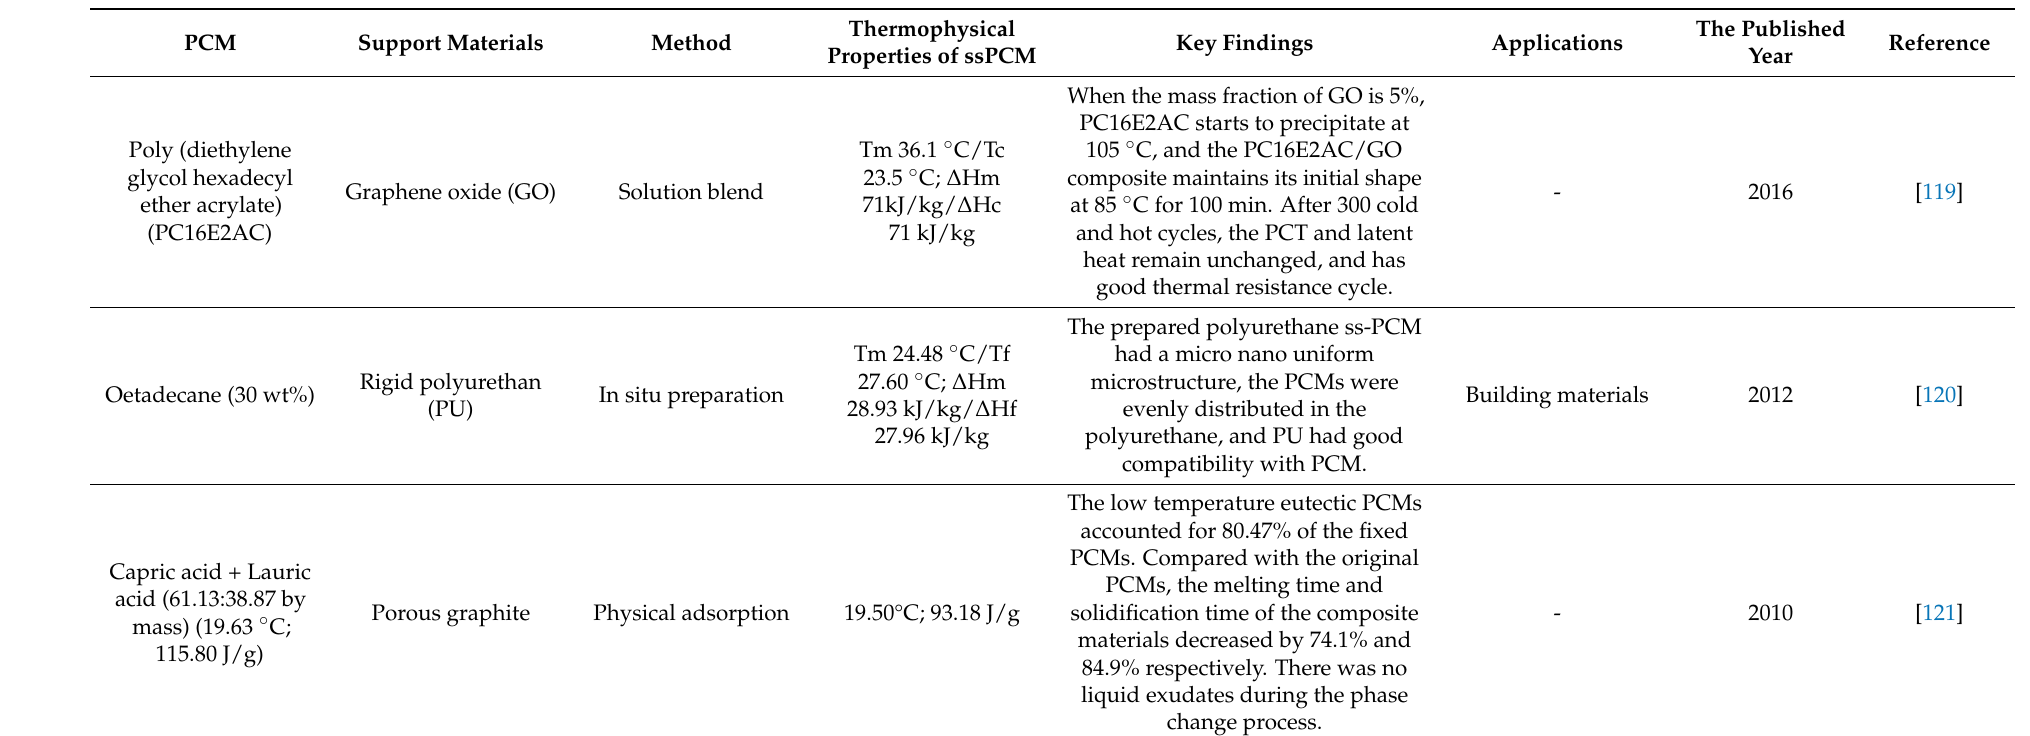
Table 8. Typical cases of shape-stabilized